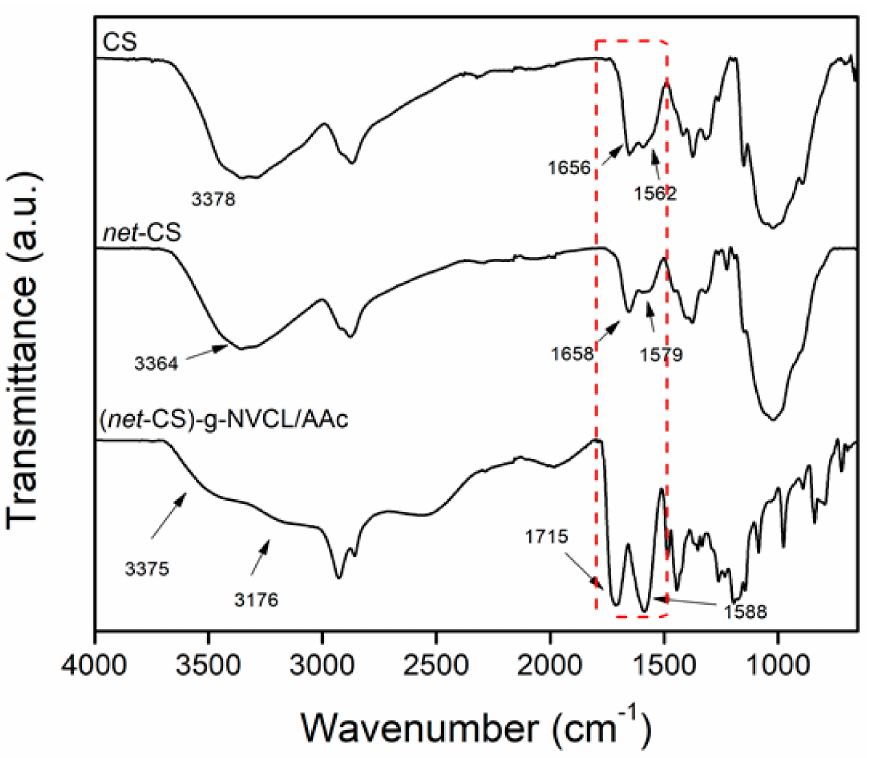
Figure 5. FTIR-ATR spectra of CS, net -CS, and ( net -CS)- g -NVCL/AAc (32 %